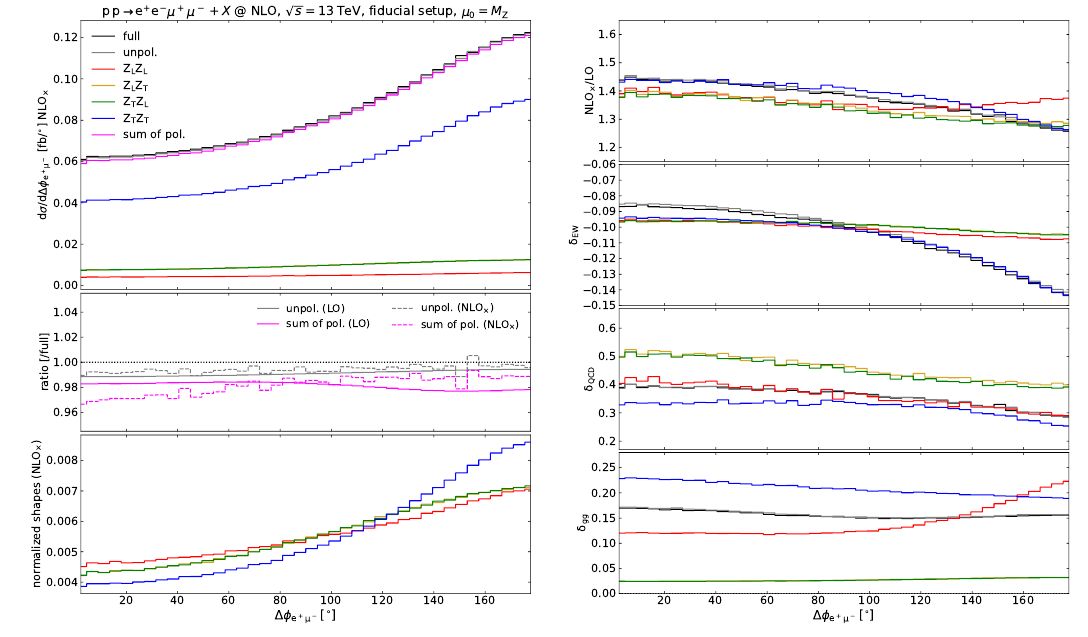
Figure 15 . Distributions in the azimuthal separation between the positron and the muon. Same structure as in figure